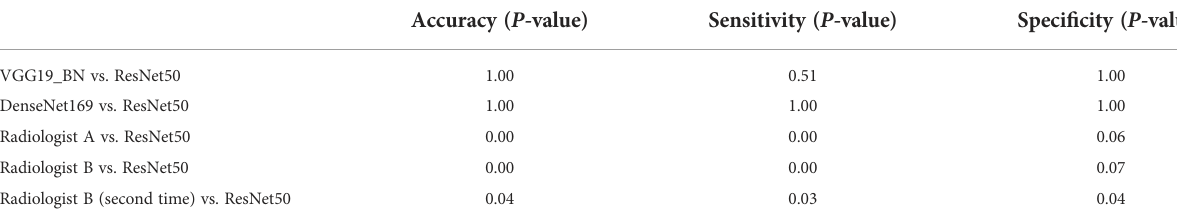
TABLE 4 Statistical signi fi cance between VGG19_BN, DenseNet169, radiologists, and ResNet50 of